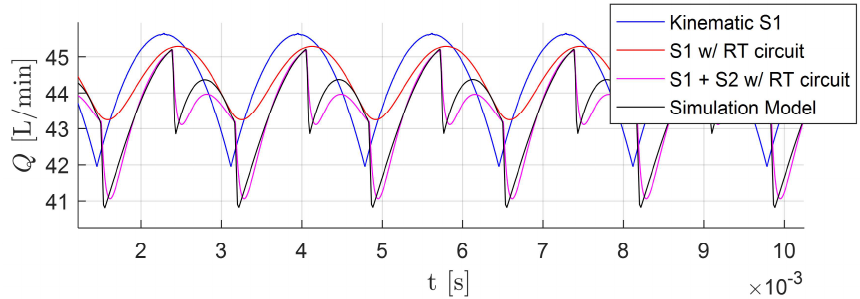
Figure 24. Recovery of simulated ripple using full hydraulic circuit by adding the kinematic and linearized pressurization ripple solution together for single-DC pressurization problem.